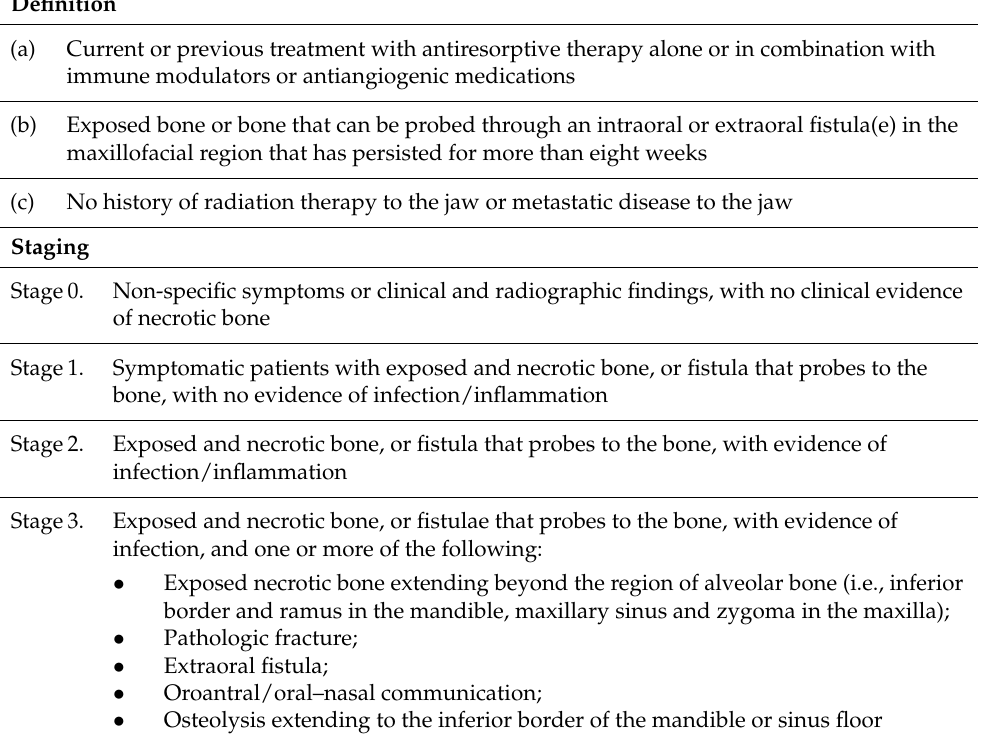
Table 1. Definition and staging of MRONJ